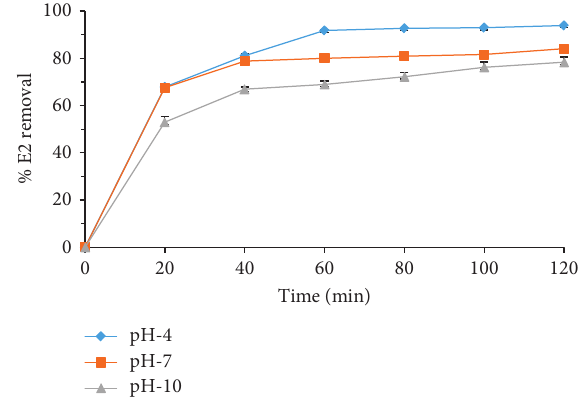
Figure 1: Removal percentage of E2 in different